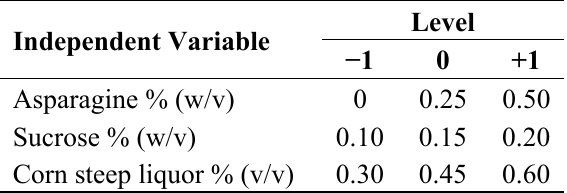
Table 2. Independent variables used in 2 3 full factorial